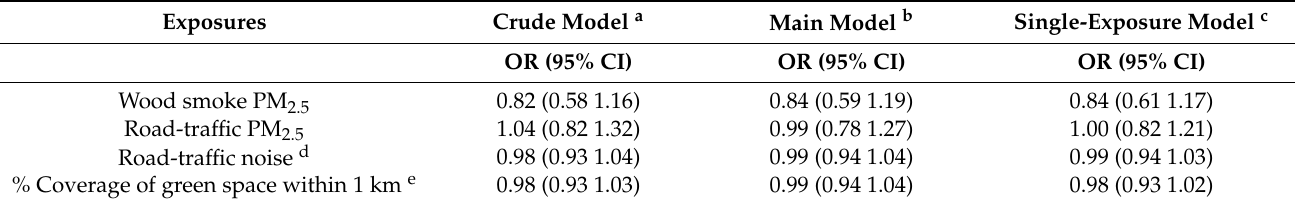
Table 5. Main model odds ratios representing association between environmental exposures and self-reported hypertension (physician diagnosed or treated